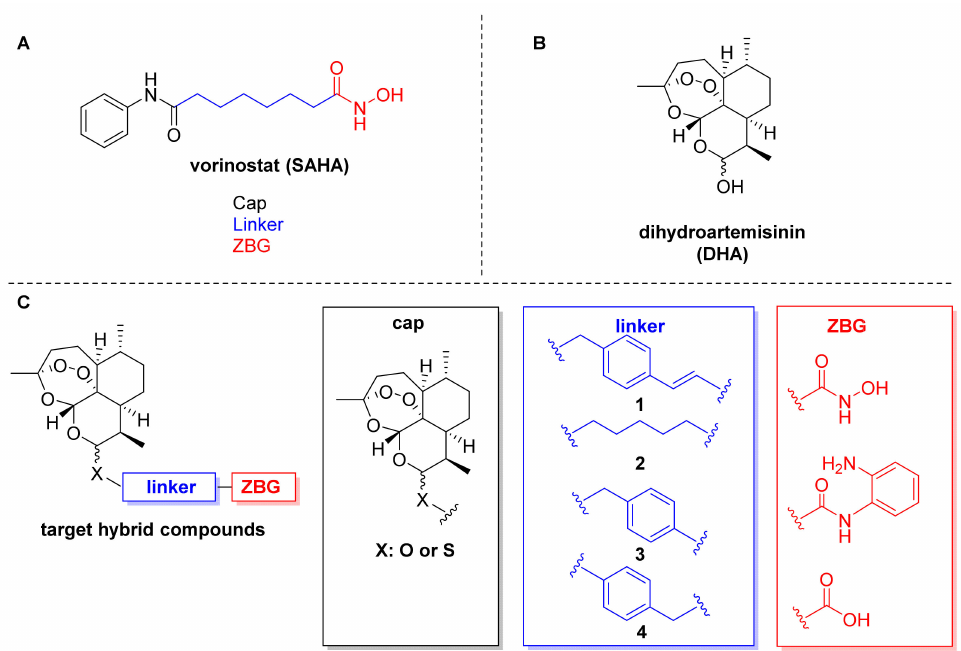
Figure 1. ( A ) HDACi pharmacophore model illustrated on the FDA-approved drug vorinostat (SAHA). ( B ) Chemical structure of dihydroartemisinin (DHA). ( C ) Compound design based on DHA as cap connected by C-10 ether or thioether groups to four different linkers and three zinc- binding